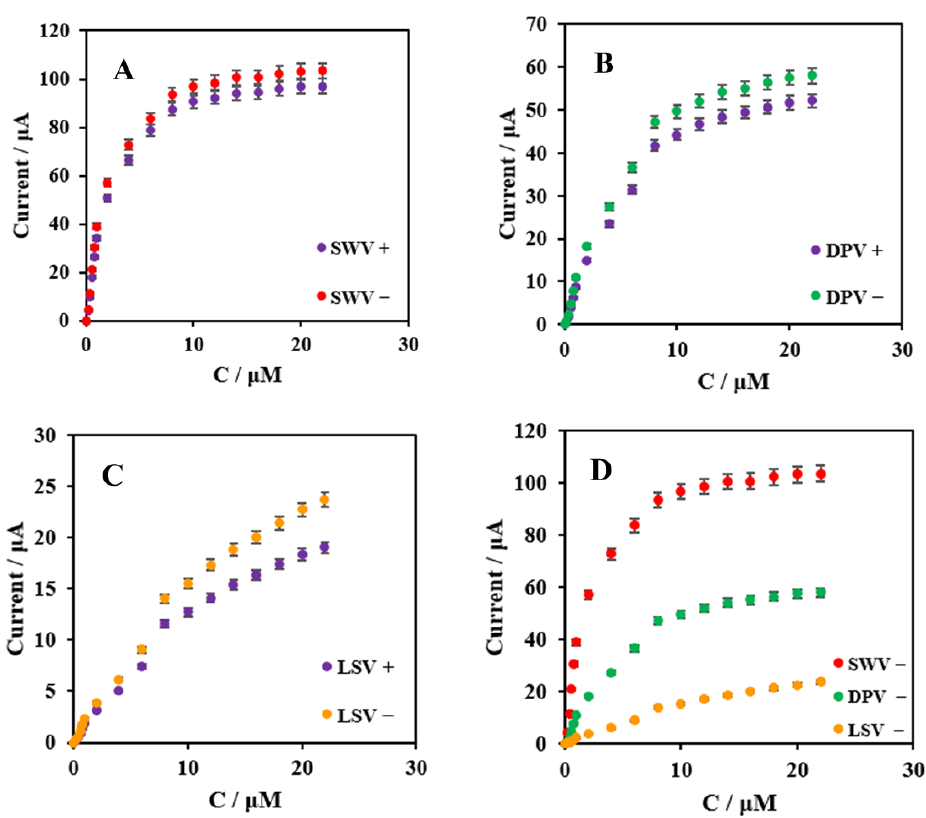
of rutin at different concentrations (0.1 μM–20 μM).